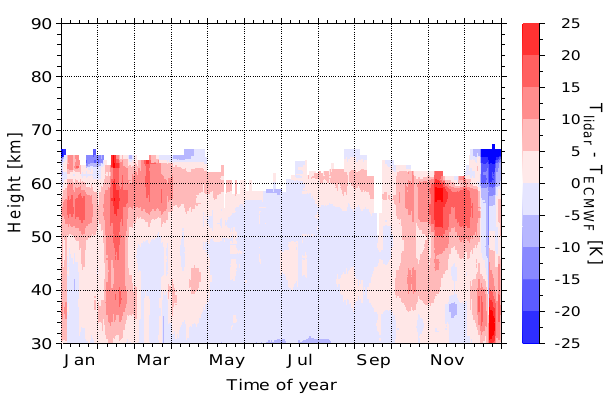
Fig. 8. Comparison of the RMR lidar seasonal temperature varia- tion to the mean ECMWF temperature at (70 ◦ N, 15 ◦ E) during the years 1997–2005. The ECMWF temperatures were smoothed with a 15-day running-average filter for this